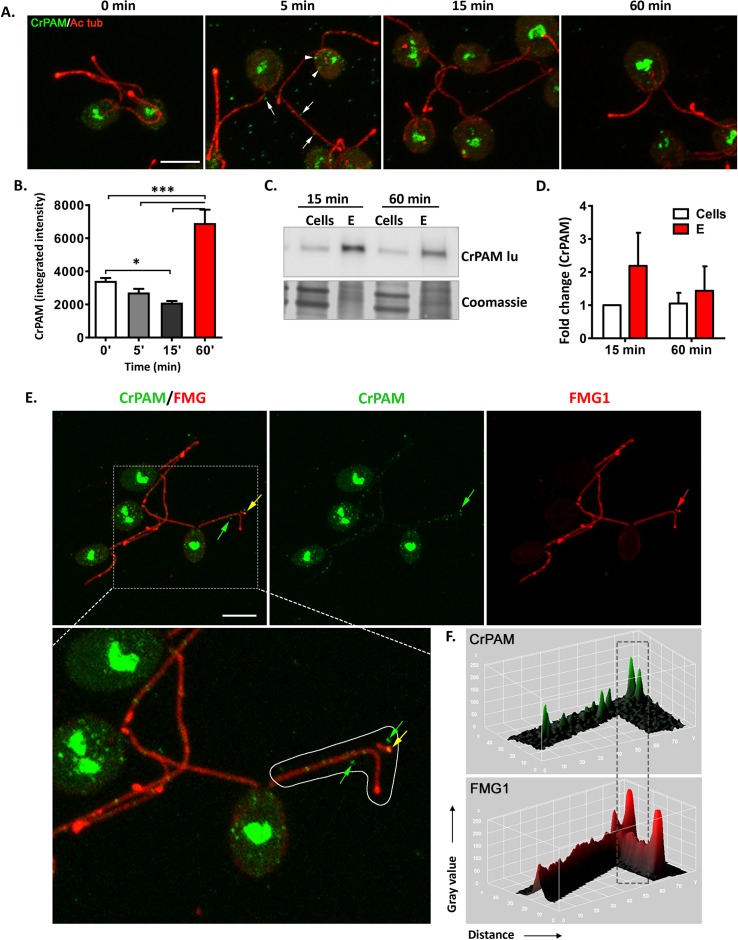
CrPAM is rapidly released in mating ectosomes.A. Maximal projection confocal images of minus and plus gametes fixed at the indicated times after mixing; permeabilized cells were stained using antibodies against the luminal domain of CrPAM (green) and Ac tub (red). CrPAM-positive ectosomes are marked by white arrows, and CrPAM-positive vesicles in the cell body are indicated by white arrowheads. B. Quantification of cell body CrPAM staining as a function of time. Data are averages of 28–37 cells ± SEM (*P < 0.01, ***P < 0.0001). C. Cells and ectosome-rich pellets (20 μg protein) prepared 15 and 60 minutes after gametes were mixed were subjected to immunoblot analysis using the CrPAM luminal antibody. D. Data for CrPAM levels in cells and their ectosome-rich pellets 15 and 60 minutes after mixing were quantified. Data are the average of duplicates, with error bars indicating the range. E. Maximal projection confocal images of cells fixed 5 minutes after minus and plus gametes were mixed, showing release of ciliary ectosomes; arrows mark puncta positive for CrPAM (green), FMG1 (red), or both FMG1 and CrPAM (yellow) (see expanded image). Scale bar = 5 μm. F. Surface intensity plots of CrPAM and FMG1 staining along the cilium outlined in panel E. The underlying numeric data for this figure can be found in S1 Data. Ac tub, acetylated tubulin; FMG1, flagellar membrane glycoprotein 1.